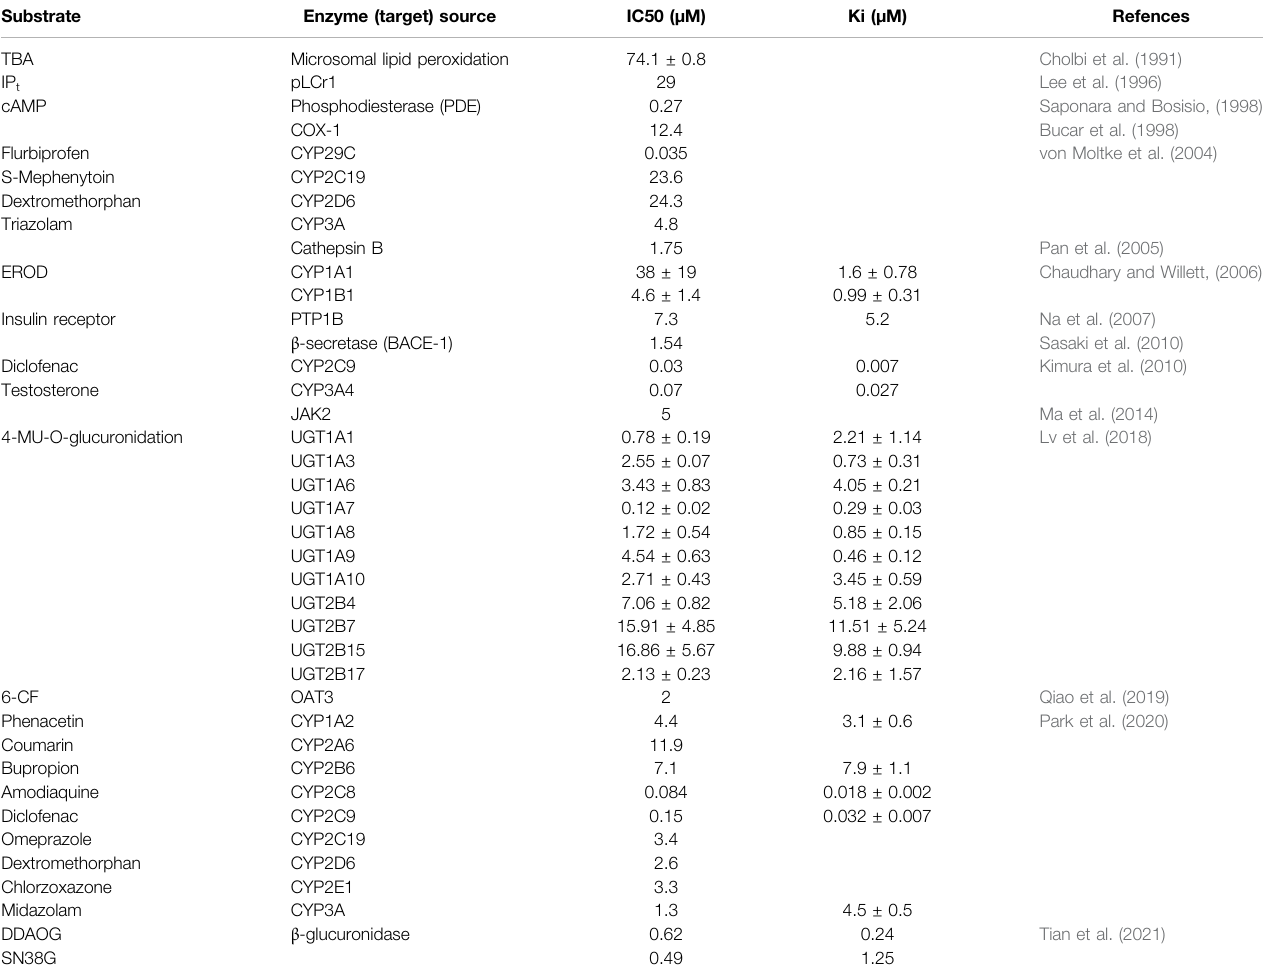
TABLE 3 | The inhibitory effects of AMF on different enzymes (targets).